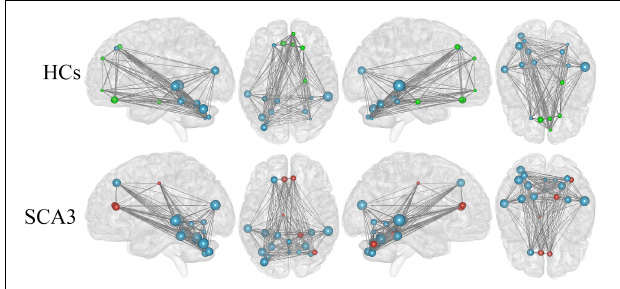
FIGURE 4 | Hub regions identified by nodal degree in the HCs and patients with SCA3. The node sizes indicate their relative degree ( D nod ). A node was identified as a hub if its normalized nodal degree was higher than 1 SD of all the nodes of the network. Red nodes represent the hubs identified only in the SCA3 group. Green nodes represent the hubs identified only in the HC group. Blue nodes represent the hubs identified in both groups. HC, healthy controls; SCA3, spinocerebellar ataxia